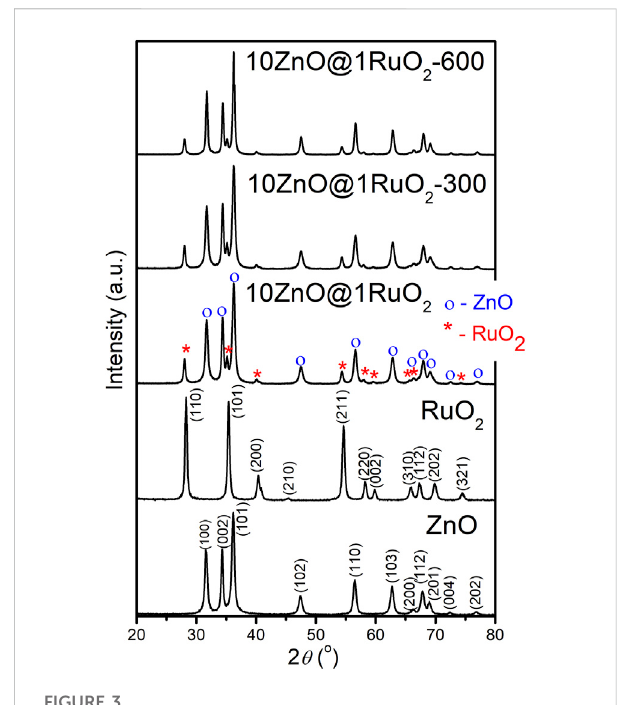
FIGURE 3 XRD patterns of the catalyst